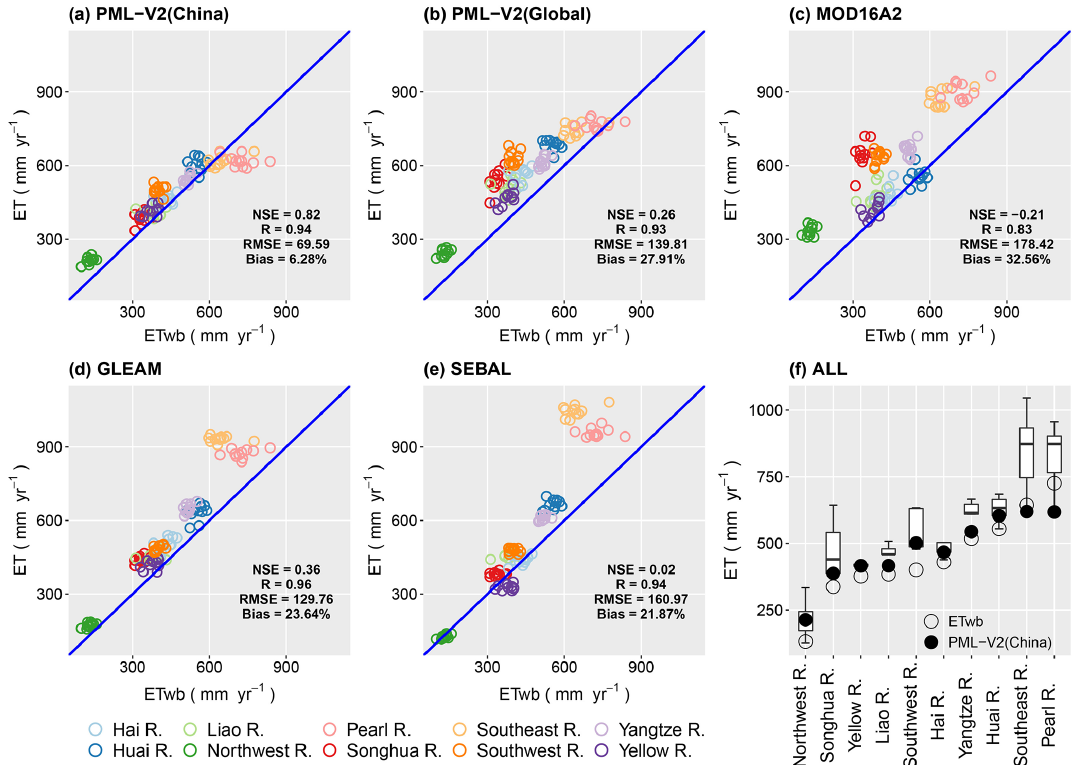
Figure 9. Annual evapotranspiration (ET) of (a) PML-V2(China), (b) PML-V2(Global), (c) MOD16A2, (d) GLEAM, and (e) SEBAL plotted against the water-balanced derived ET (ET wb ) values for 10 major river basins over China during 2003–2013. The boxplot in panel (f) shows a multiyear mean of the five ET products above per river